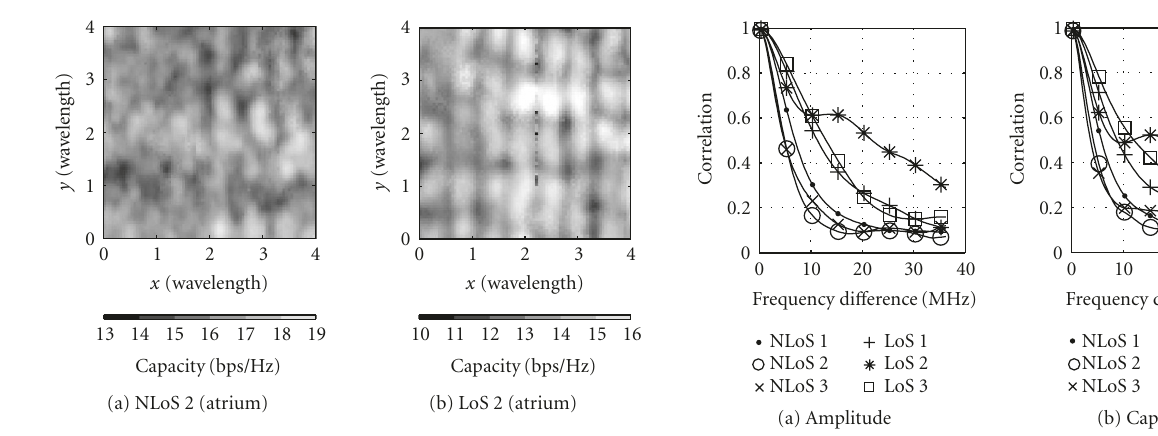
4 MIMO-OFDM channel capacity (cid:0)